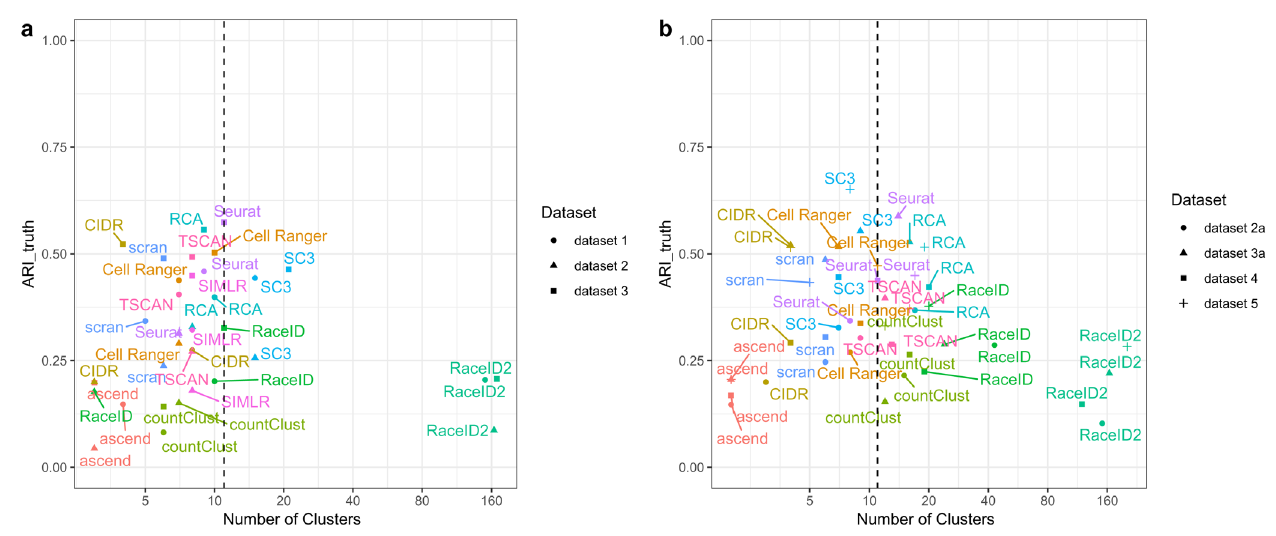
Figure 2. ARI_truth of each method in each dataset, as indicated by different shapes, with regards to the supervised cell labeling versus the number of clusters. The dashed line indicates the number of cell populations estimated by the supervised cell labeling approach. ( a ) First evaluation with methods available in R 3.4.3. ( b ) Second evaluation with methods available in R